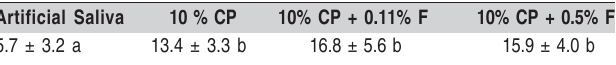
For microhardness analysis, means followed by different uppercase letters differ statistically vertically and different lowercase letters differ statistically horizontally (Tukey test, p<0.05) (CP – carbamide peroxide). For %SMHR, values followed by distinct superscript letters differ statistically (Kruskal Wallis and Dunn’s test, p<0.05). Table 2 Analysis of caries lesion depth (mm) after pH- cycling model (Means ± SD,